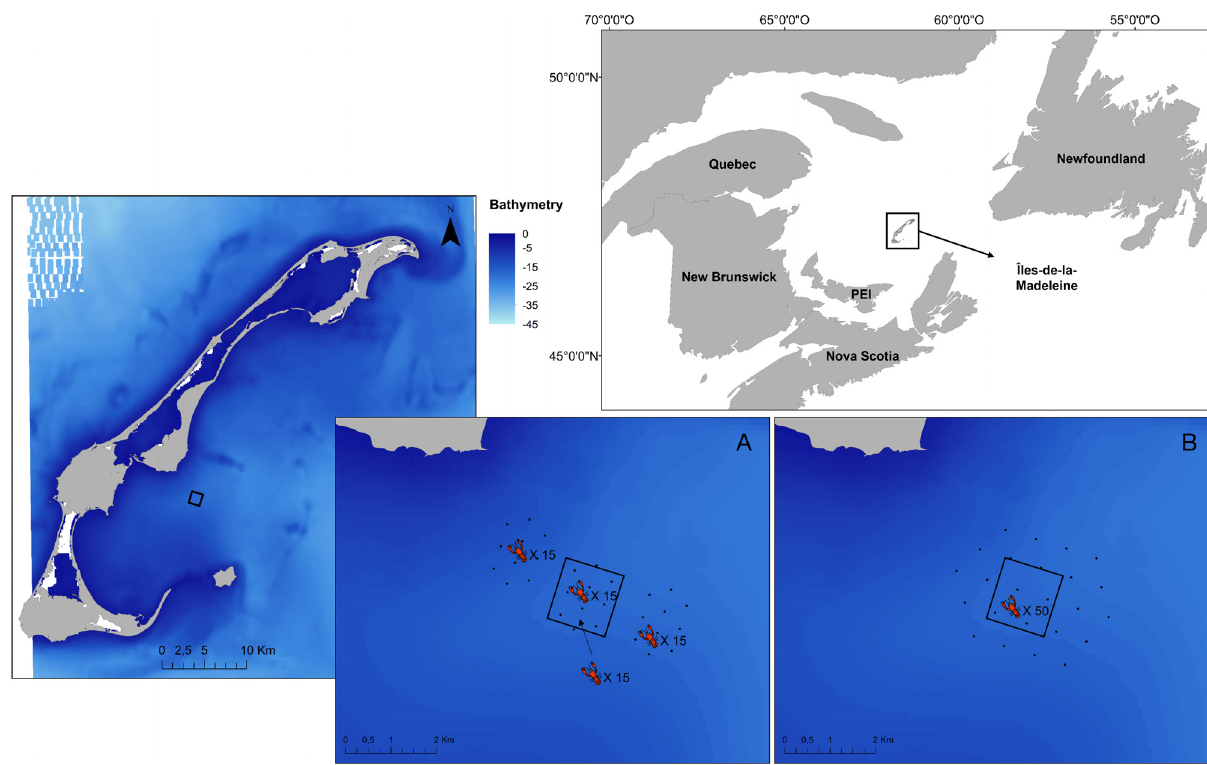
Fig. 1. Location of the studied mussel farm (black polygon) in the Baie de Plaisance, Iles-de-la-Madeleine, Canada, where (A) 60 lobsters in 2014 and (B) 50 lobsters in 2017 were acoustically tagged and released. The black dots represent the locations of the acoustic